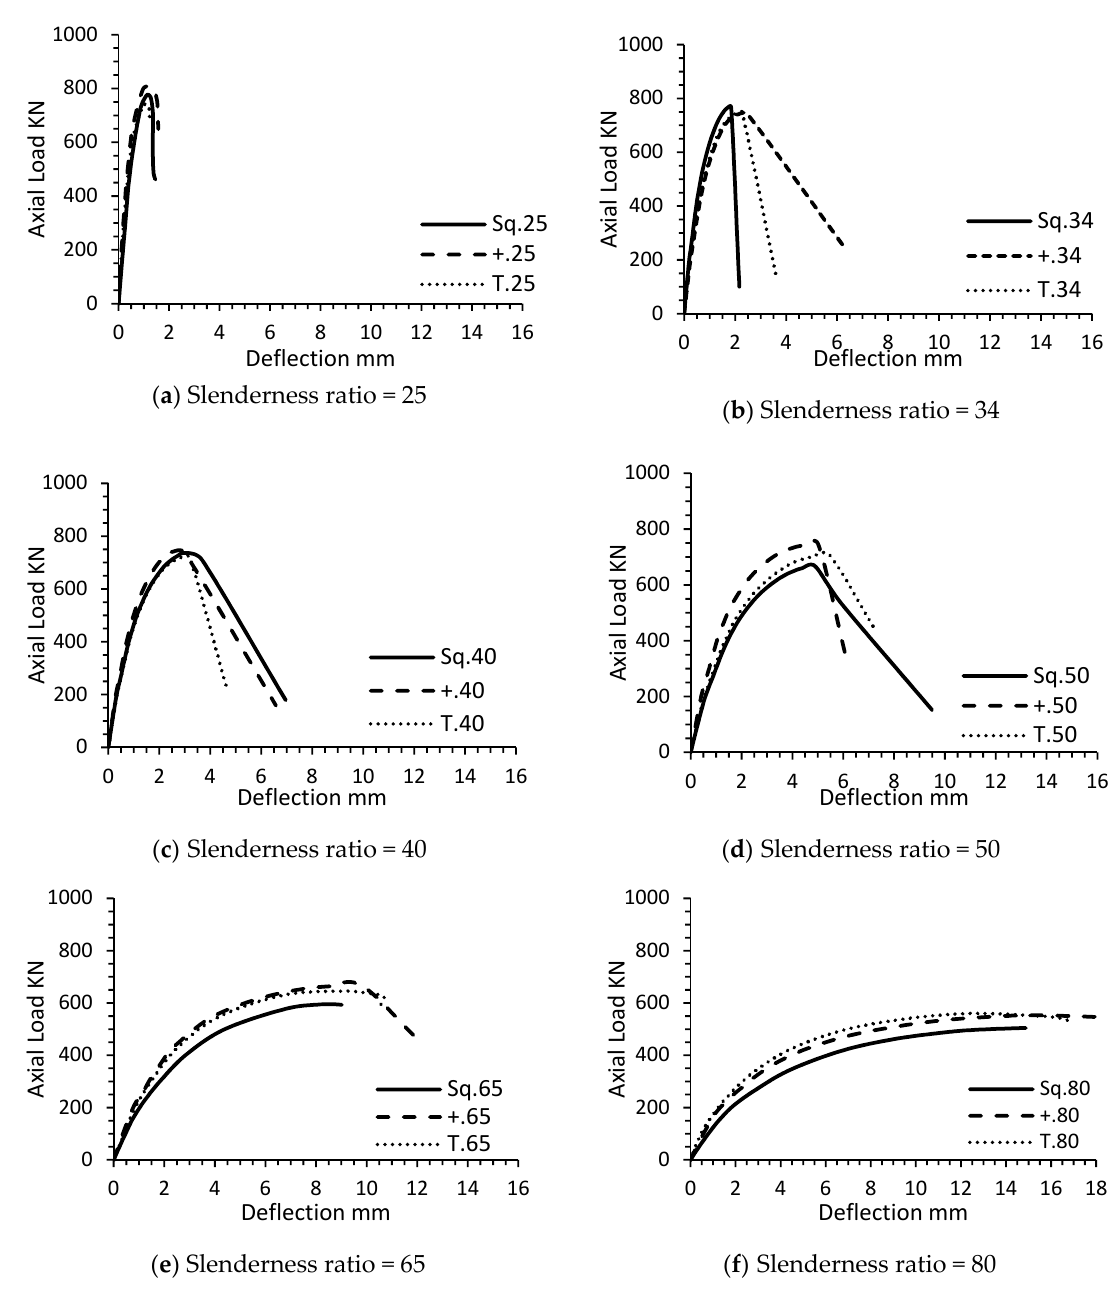
Figure 9. Influence of column cross-section shape on load-deflection curves.